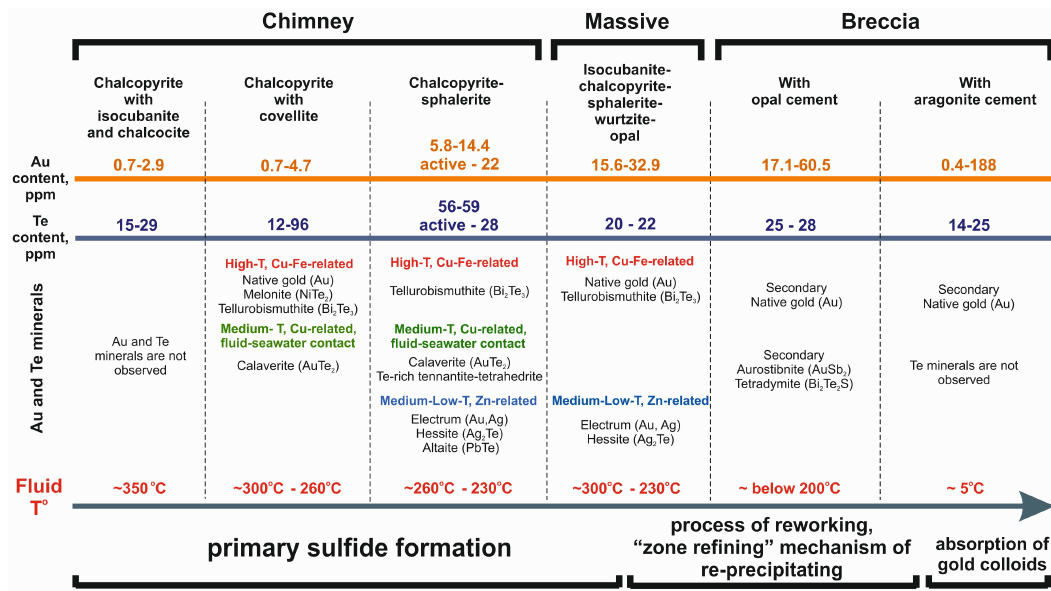
Figure 16. The distribution of Au and Te minerals in chimneys, massive sulphide and breccia from Semyenov-2 hydrothermal field.